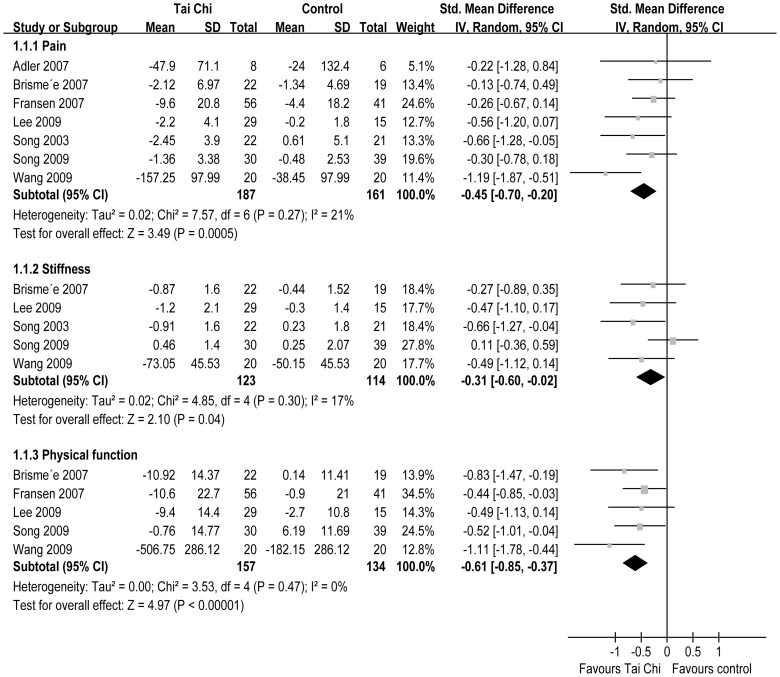
A Forest plot of the meta-analyses of RCTs comparing Tai Chi group with control group for change in pain, stiffness and physical function.Each block represents a study and the area of each block is proportional to the precision of the mean treatment effect in that study. The horizontal line represents each study's 95% confidence interval (CI) for the treatment effect. The centre of the diamond is the average treatment effect across studies, and the width of the diamond denotes its 95% CI.